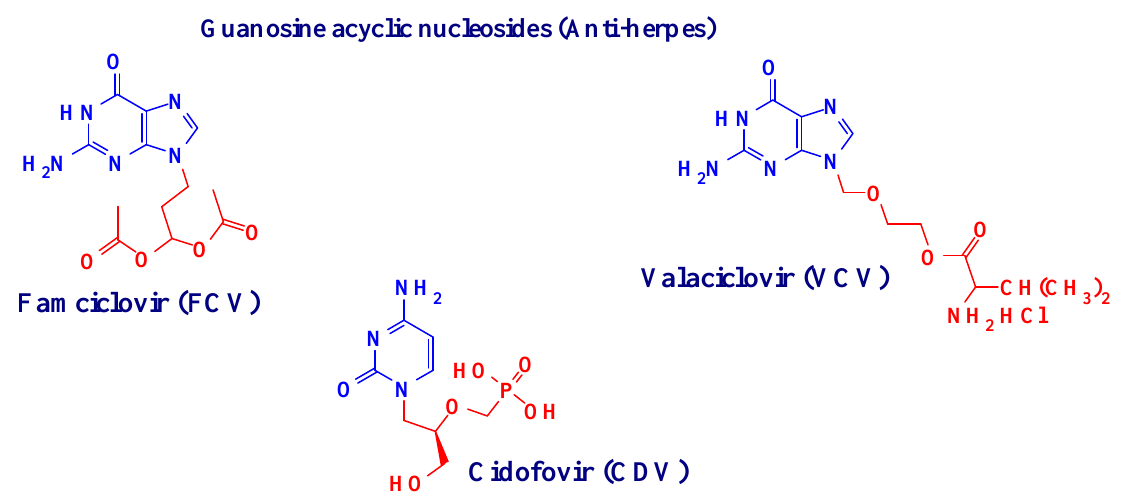
Figure 2. Some anti-viral approved drugs used in clinical trials for the treatment of SARS-CoV-2. The well-known mode of action for nucleoside analogues is through the triphosphate (TP) active form, which allows these analogues to act as competitive inhibitors of the viral DNA polymerase [36]. To become active, the free OH group undergoes three intracellular phosphorylation reaction that convert the nucleoside analogues into (TP) forms. Our newly synthesized compounds are nucleoside analogues that bear the free OH group, tigation into their mode of action must be performed.